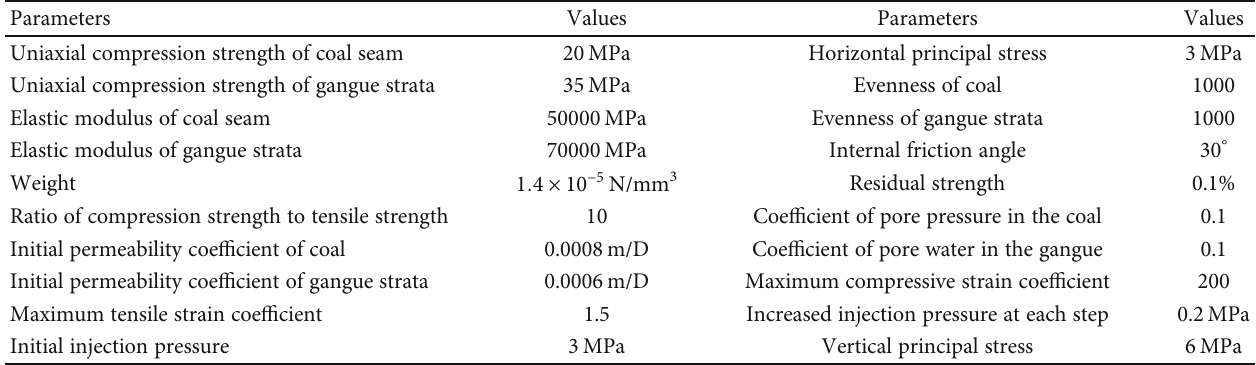
Figure 2: The geometry model of hydraulic fracturing with RFPA 2D -Flow simulation. Table 1: Parameters of RFPA 2D -Flow